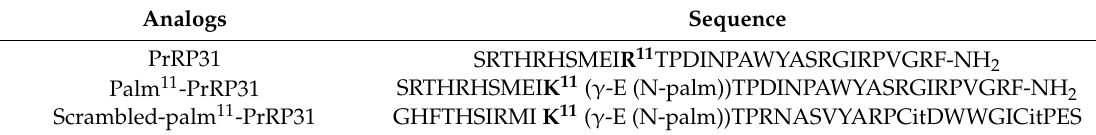
Table 1. Structure of human prolactin-releasing peptide 31 (PrRP31) and its